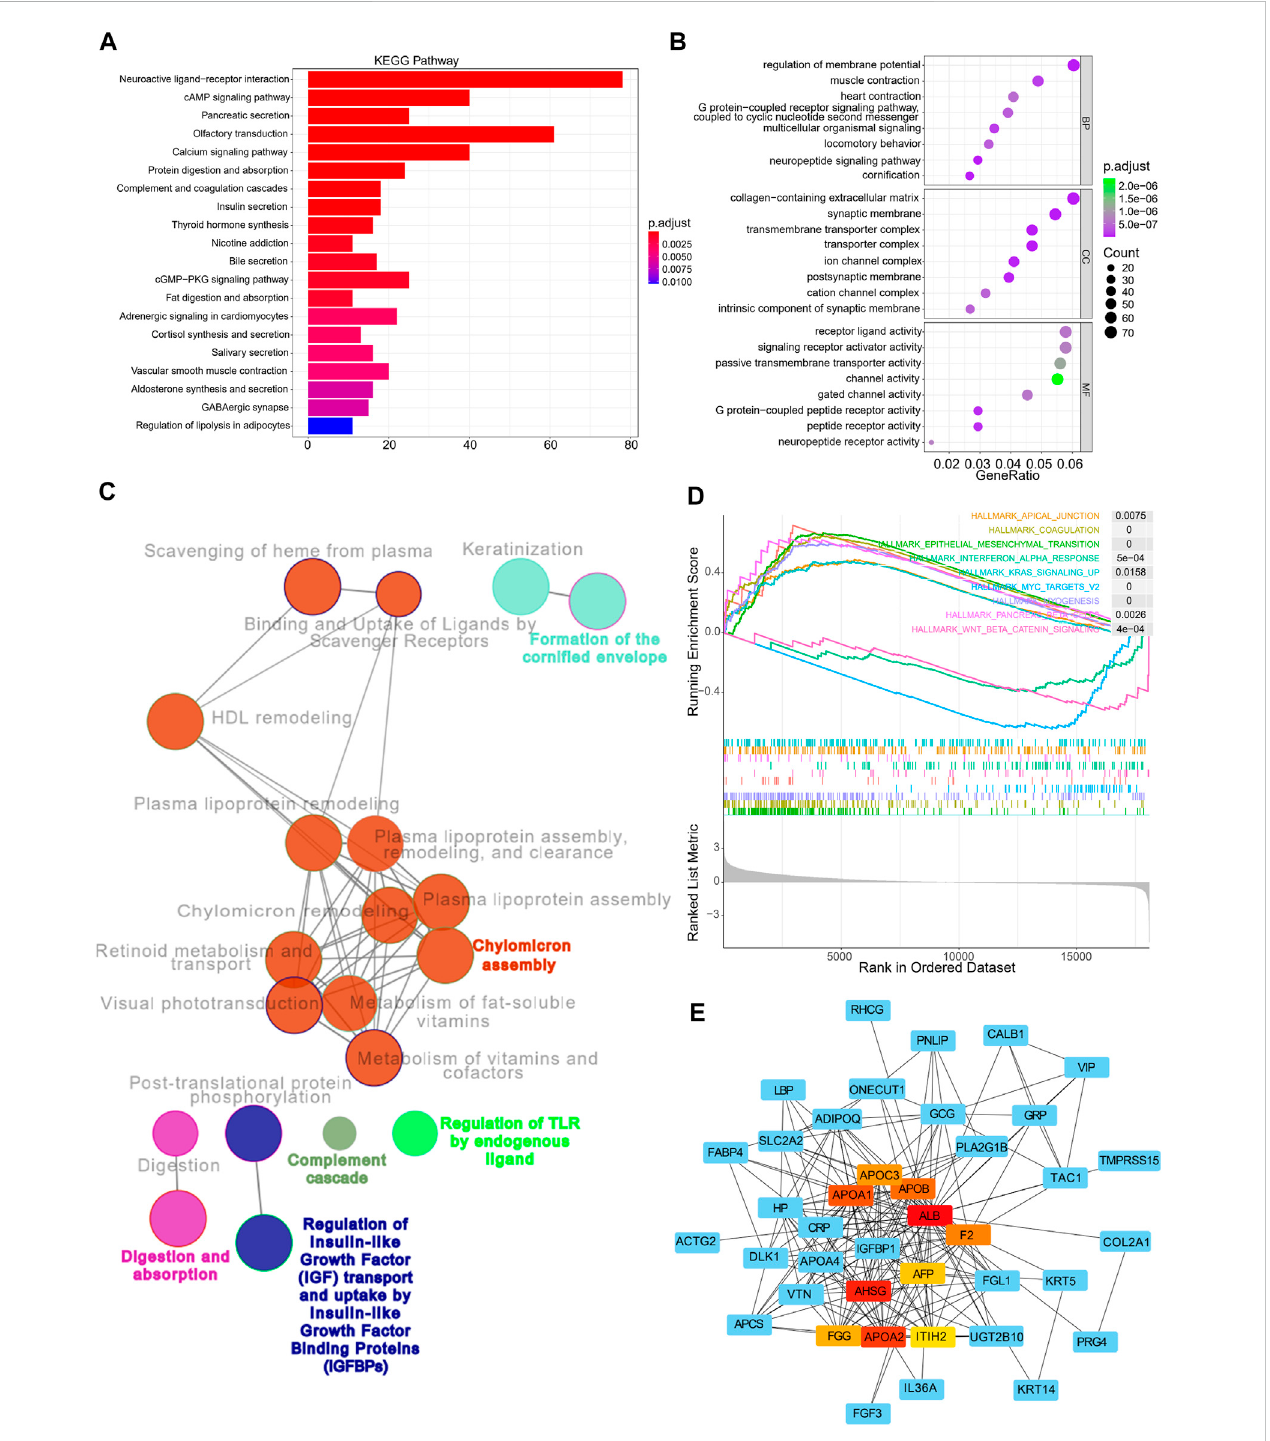
FIGURE 7 Functional annotation, genomic enrichment analysis of gastric cancer samples with different risks (A) KEGG enrichment analysis shows the top 20 pathways in high and low risk groups. (B) Dot plot shows enriched GO terms of upregulated 11 gene signature. (C) Functional access network shows transcriptome pro fi les of different risk groups. (D) GSEA enrichment analysis shows the 9 hallmarks gene sets in the high and low risk groups. (E) The protein – protein interaction network of the high and low risk